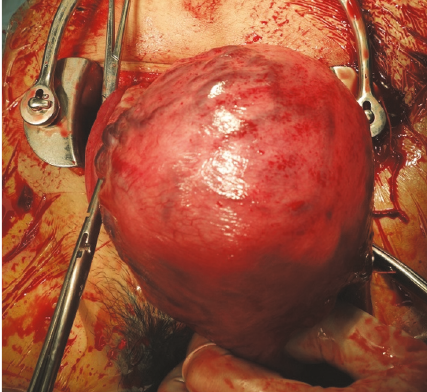
Figure 2: Intraoperative finding: blood vessels on the uterine surface at the placental implantation site are engorged.